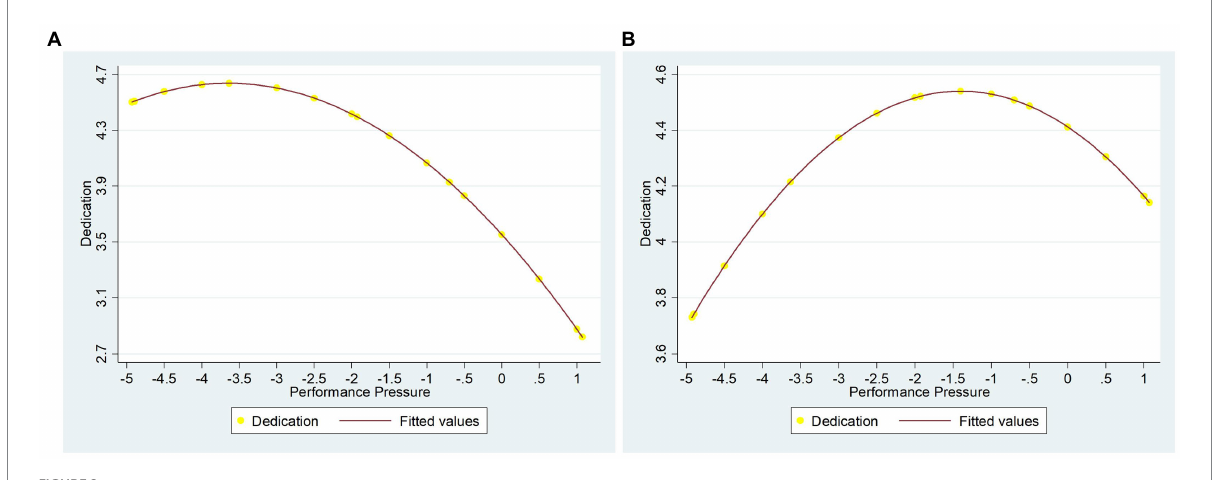
FIGURE 2 The incentive effect of performance pressure on dedication. (A) the direct effect of performance pressure on dedication; (B) the moderation effect of mission valence between performance pressure and dedication. The dotted line indicates the midpoint, and the solid line indicates the inflection point.